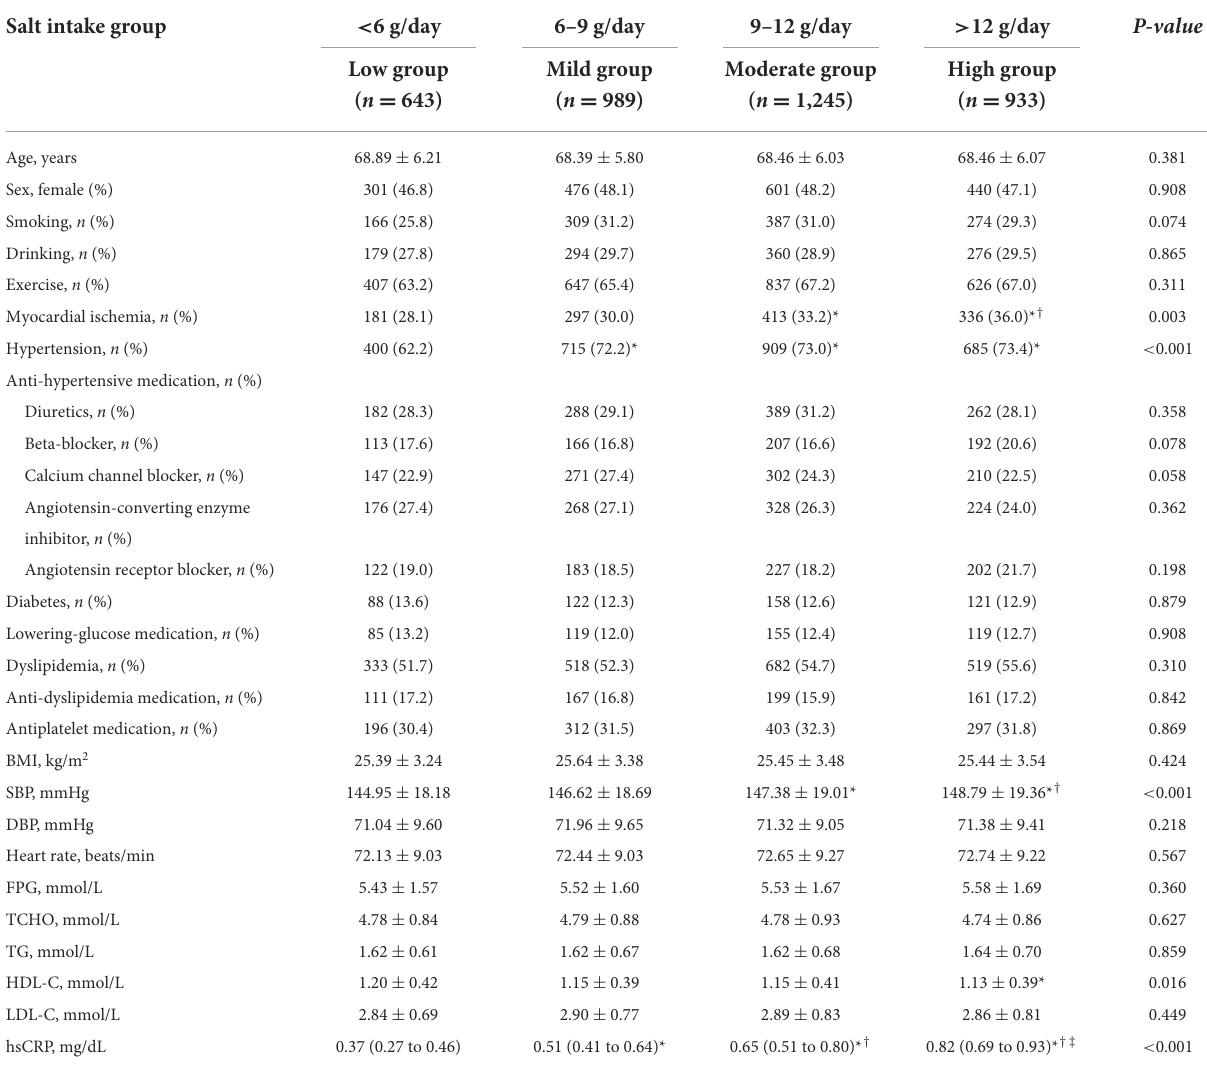
TABLE 1 Demographic and clinical characteristics of the study